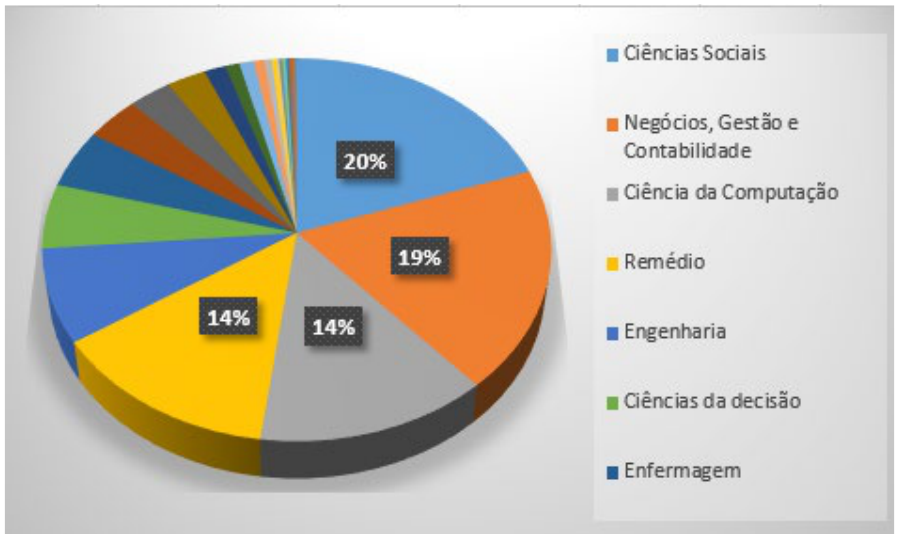
Figure 5. Analysis of the percentage of areas of knowledge of the